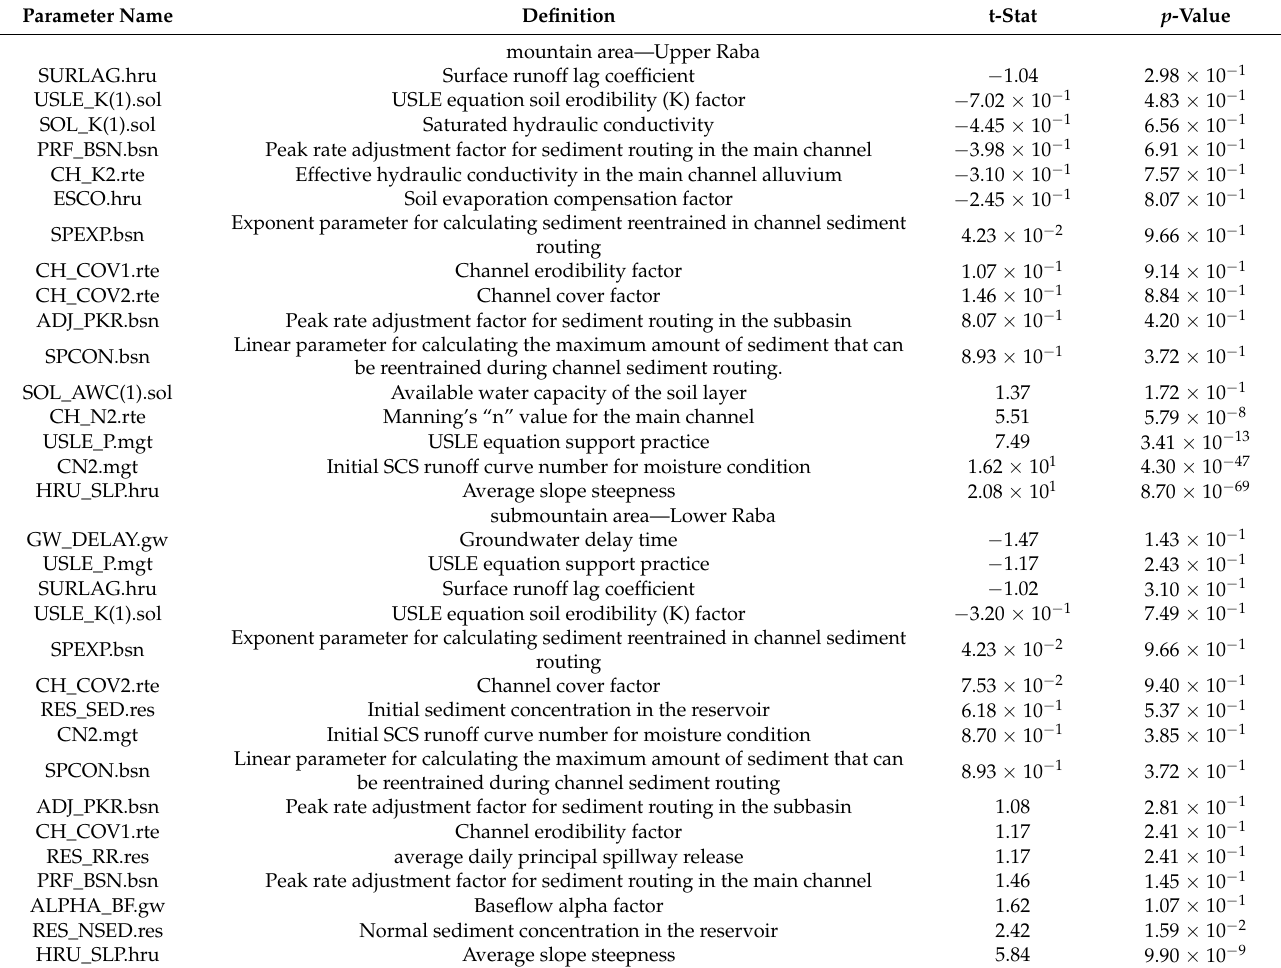
Table 1. Calibration of SWAT parameters for the upper and lower Raba basin sorted by